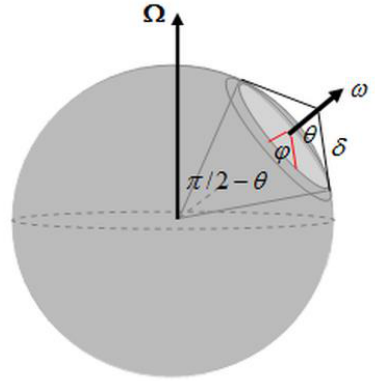
Figure 1. The β -cone approximation and the conical coordinates.